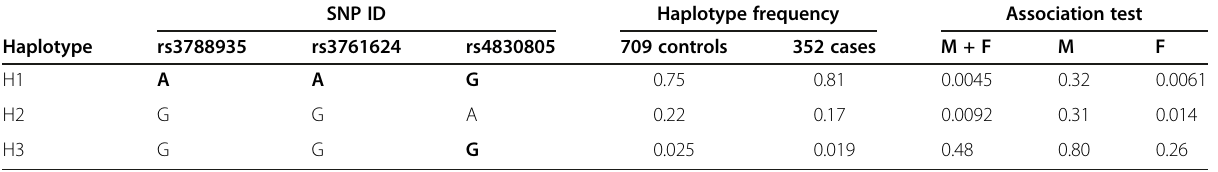
Table 2 Association of haplotypes in TLR8 with AR in the Swedish population SNP